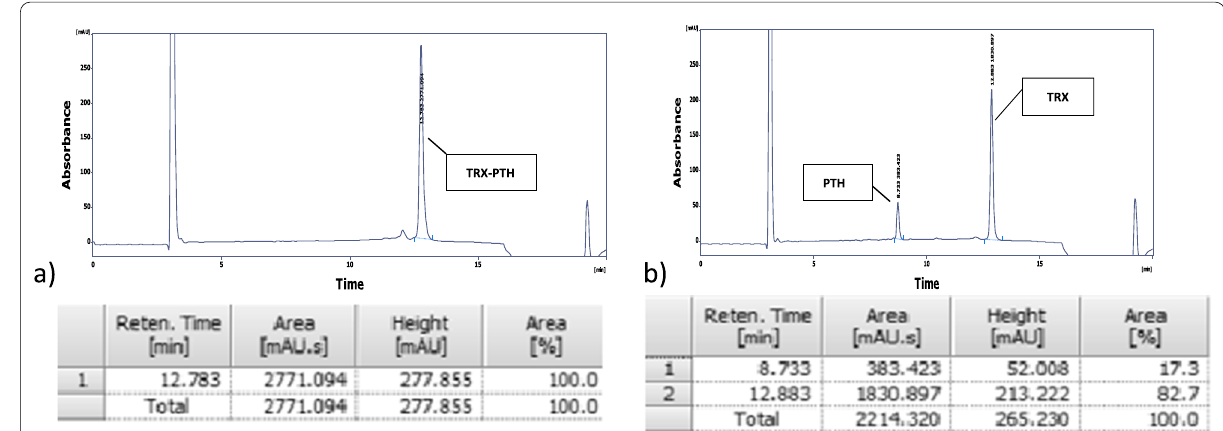
Fig. 3 HPLC analysis of the enzyme reaction on TRX-PTH substrate, a undigested substrate, b digested substrate